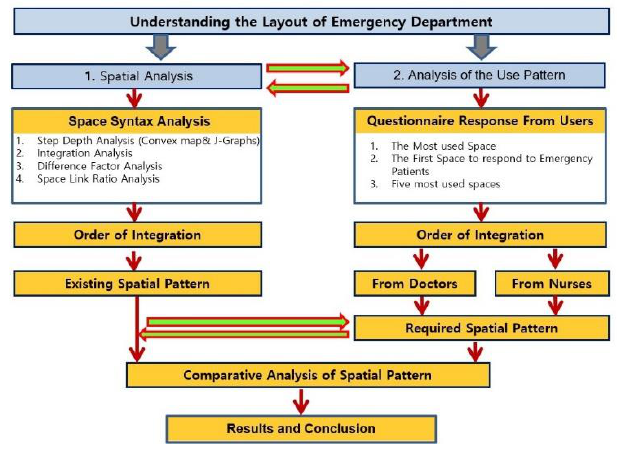
Fig. 1. Conceptual